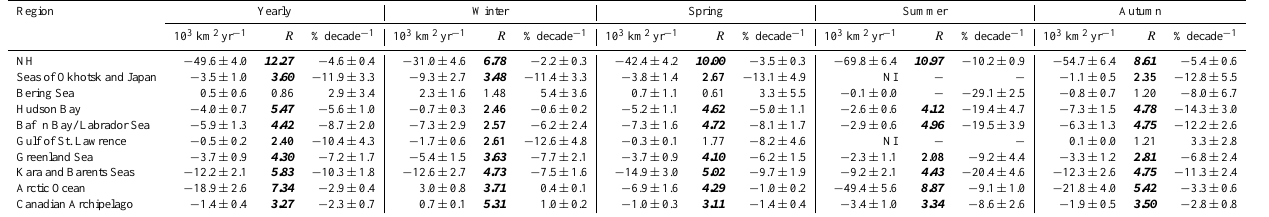
Table 2. Yearly and seasonal Arctic sea ice area trends for the period 1979–2010 with estimated standard deviations ∗ . Region Yearly Winter Spring Summer Autumn